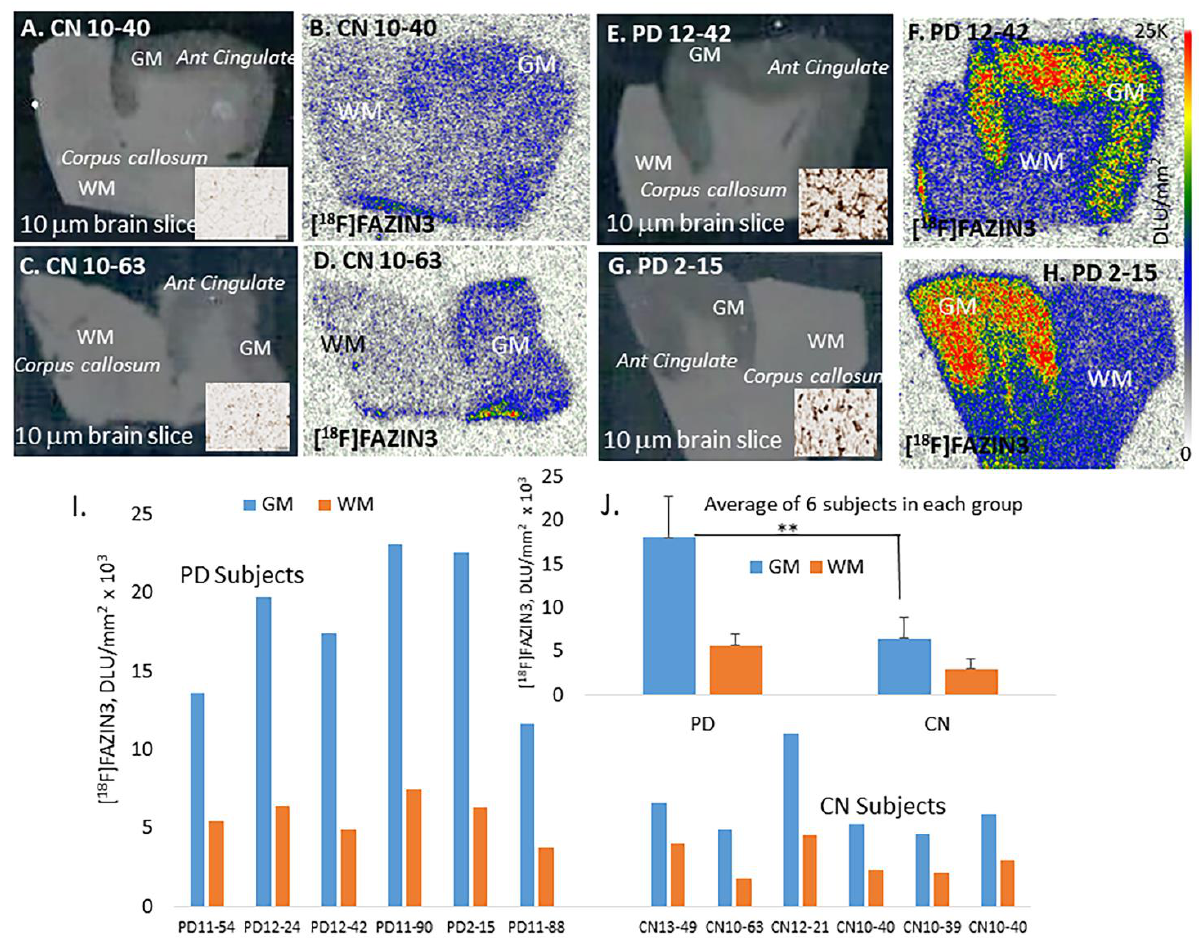
Figure 2. [ 18 F]FAZIN3 binding to MAO-A: ( A , C ). Brain slices (10 µ m) of CN subjects show absence of LB in the GM regions of anterior cingulate (inset images UIHC stained); ( B , D ). Binding of [ 18 F]FAZIN3 in the CN brain GM and lower levels in corpus callosum, WM. ( E , G ). Brain slices (10 µ m) of PD subjects showing abundant LB in the GM regions of anterior cingulate (inset images UIHC stained). ( F , H ). Binding of [ 18 F]FAZIN3 in the PD brain GM was significantly greater compared to that of CN GM. [ 18 F]FAZIN3 binding was seen in all CN and PD subject, with GM showing higher levels compared to WM. PD brains showed greater [ 18 F]FAZIN3 in GM regions compared to control subjects. ( I ). Plot of GM and WM of all subjects show PD subjects exhibited significantly higher binding of [ 18 F]FAZIN3 in GM compared to CN. ( J ). Plot shows averages of all PD and CN subjects (** p < 0.01 for PD GM versus CN WM). Ratio of PD GM/WM = 3.15 whereas CN GM/WM = 2.17. Gray matter of PD subjects had >100% increase in [ 18 F]FAZIN3 compared to control subjects.